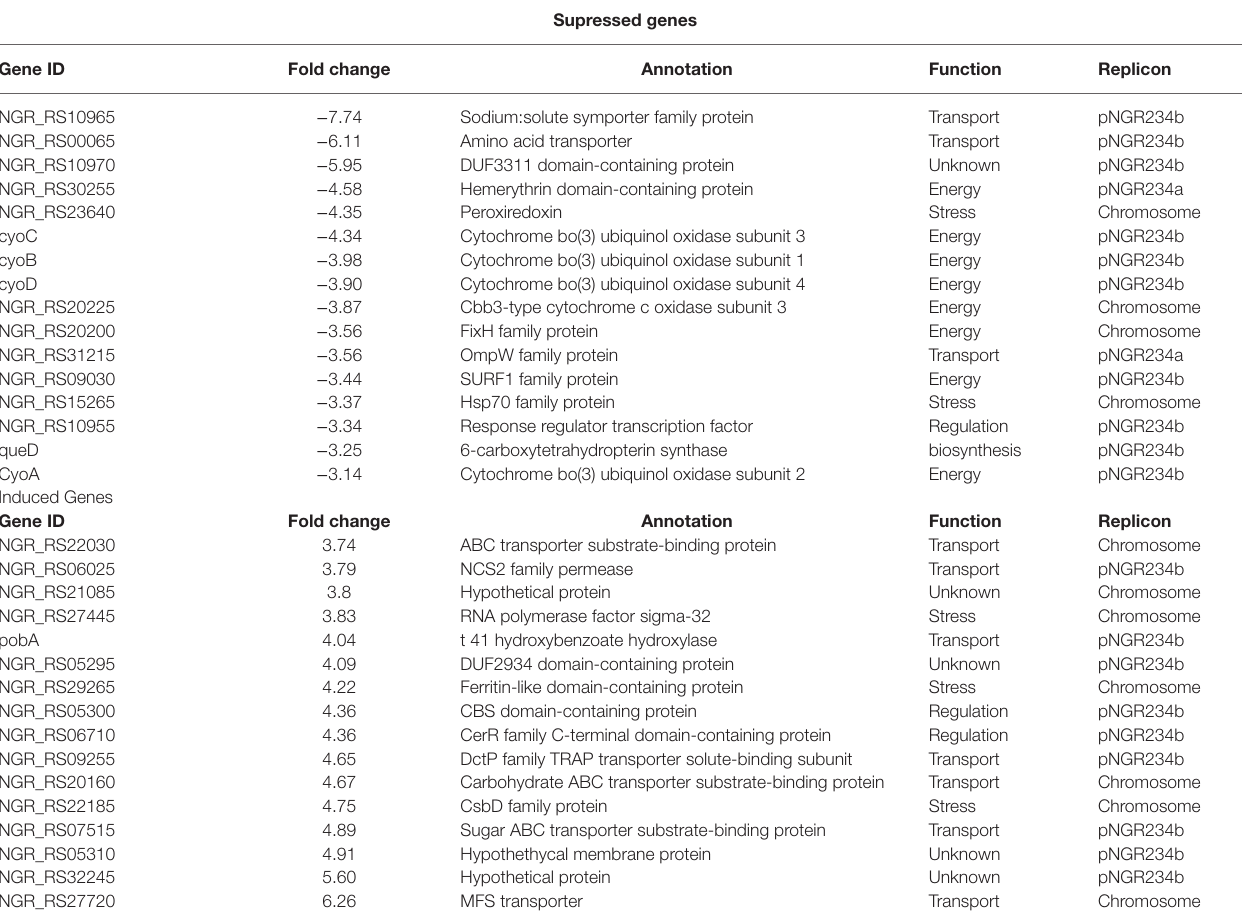
TABLE 2 | Selection of differentially expressed genes in the S. fredii NGR234 Δ rpuS strain under pyruvate-utilizing